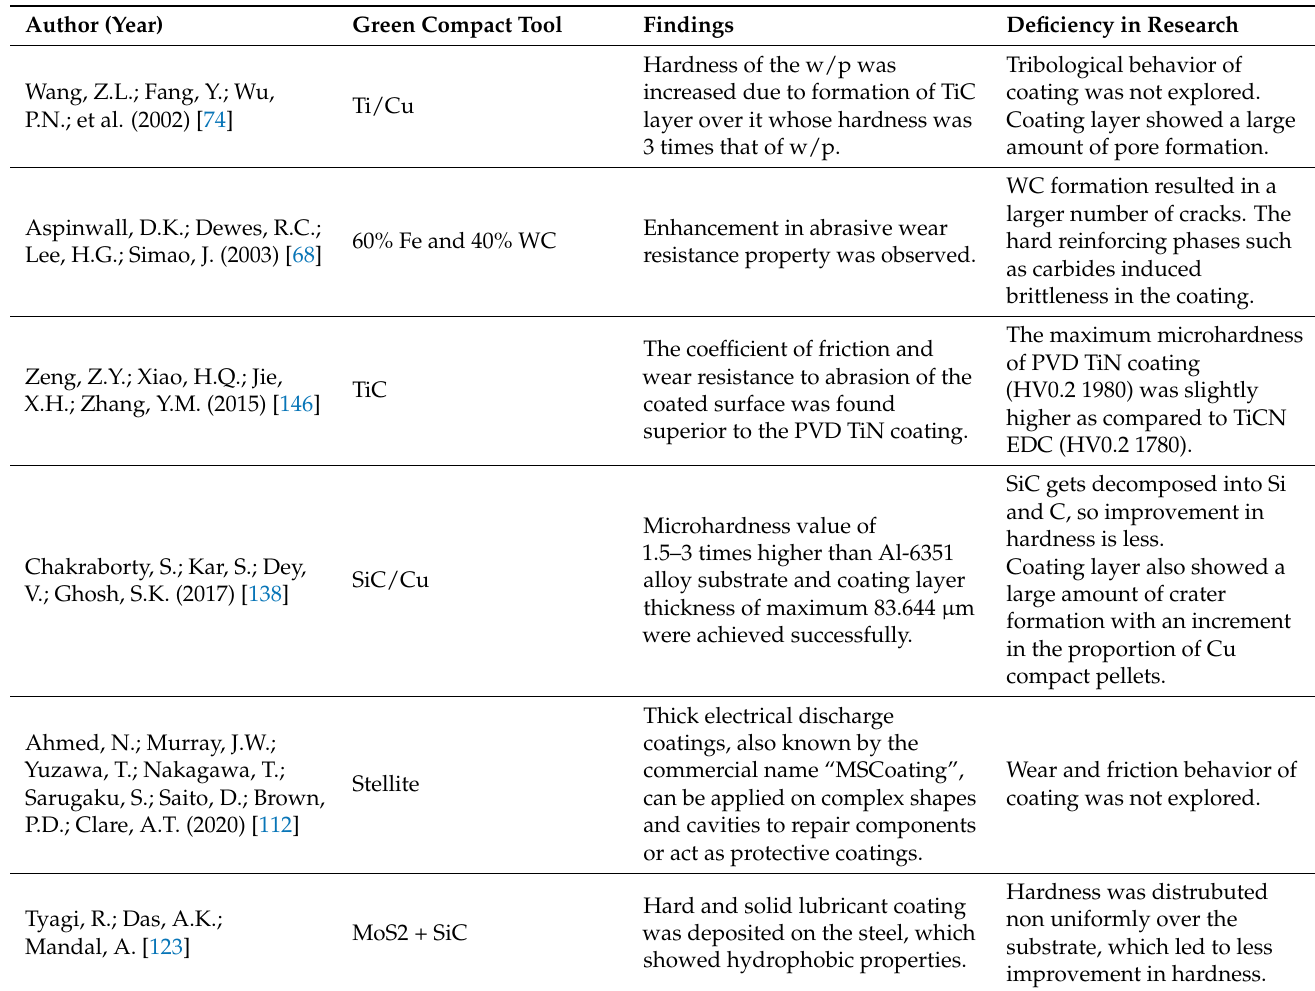
Table 6. The summary of past literature